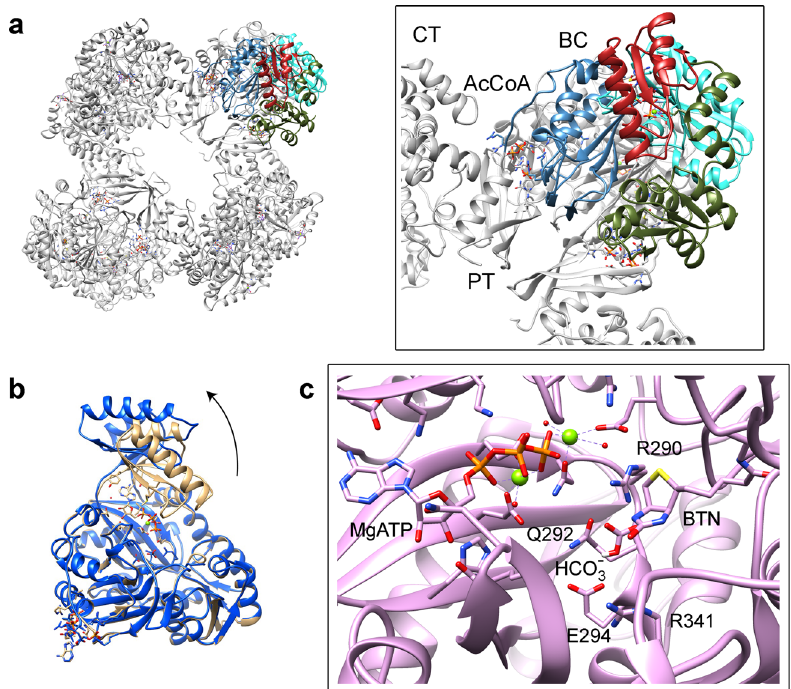
Fig. 4 | Atomic models for the BC domain during catalytic reaction. a Model of tetrameric LlPC and enlargement of a BC domain. The A sub-domain is colored in cyan, B-subdomain in red, C1-subdomain in green, and C2-subdomain in blue. The B-subdomain interacts mainly with ATP and most of the catalytic residues are located in the A-subdomain. b Overlap of BC open (blue) and a BC closed (brown)